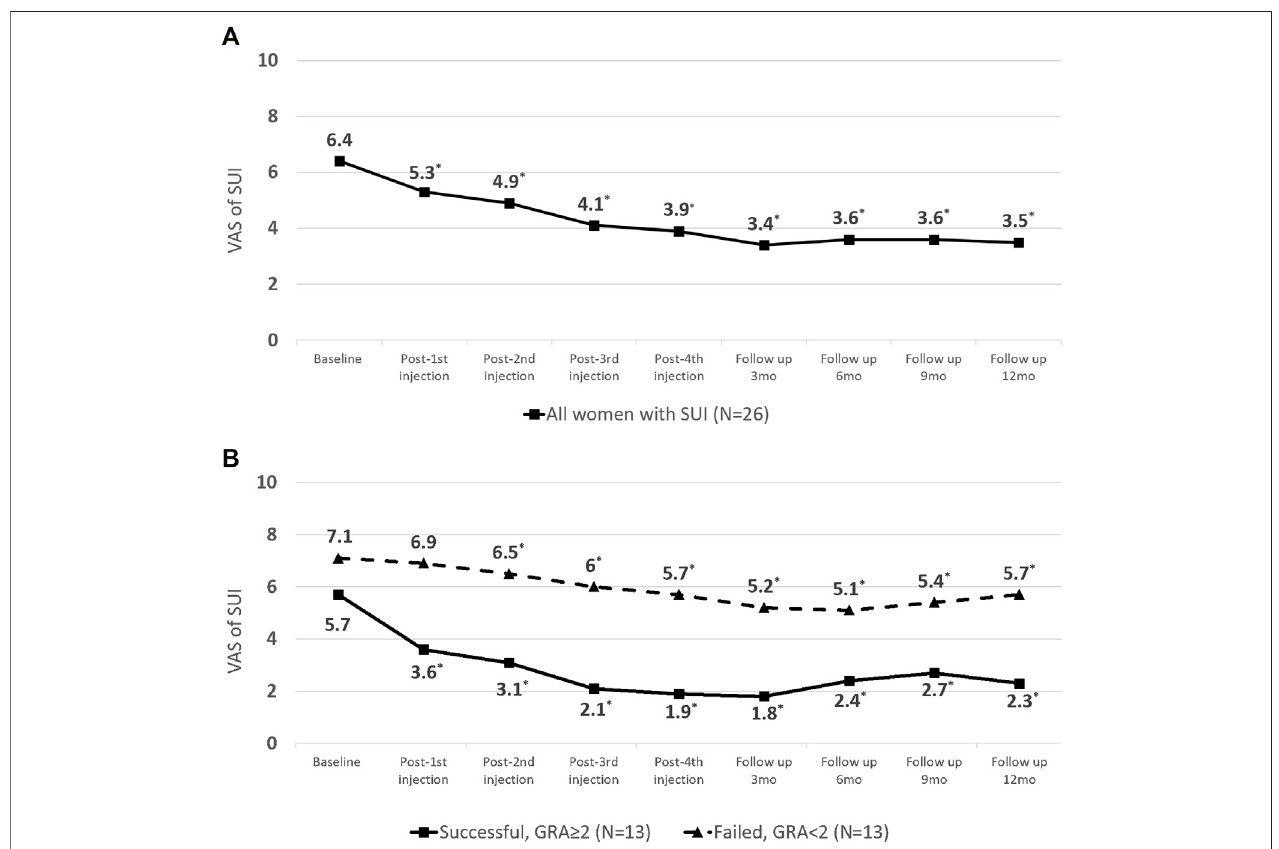
FIGURE2| Changesinvisualanaloguescale(VAS)scoreofstressurinaryincontinence(SUI)frombaselinetotheend-pointofplatelet-richplasma(PRP)treatment (A) in all patients. (B) Subgroup analysis by outcome.